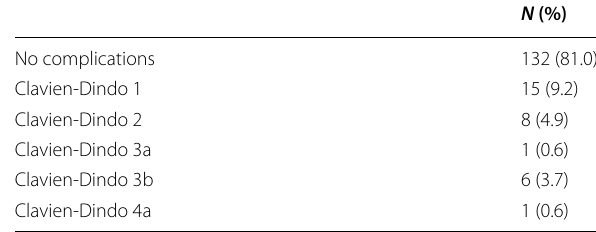
NSM negative surgical margin, BCR biochemical